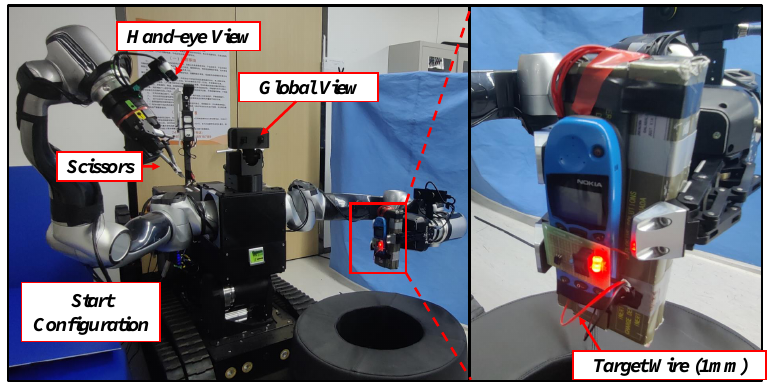
Figure 12. Setup of the teleoperation experiment (see details in Supplementary Video).